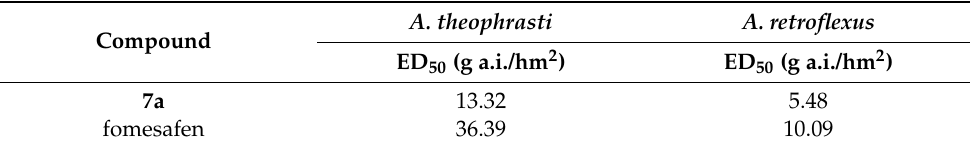
Table 3. Analysis of the herbicidal activities of selected compounds when used for the postemergence treatment of A. theophrasti and A. retroflexus in a greenhouse setting.